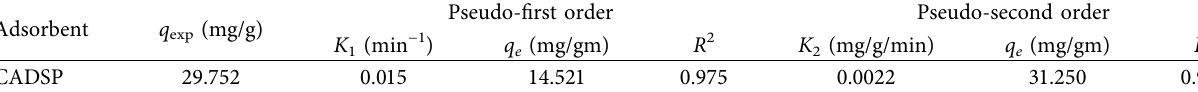
Table 2: Kinetic parameters determined for the Cr(VI) biosorption onto CADSP.